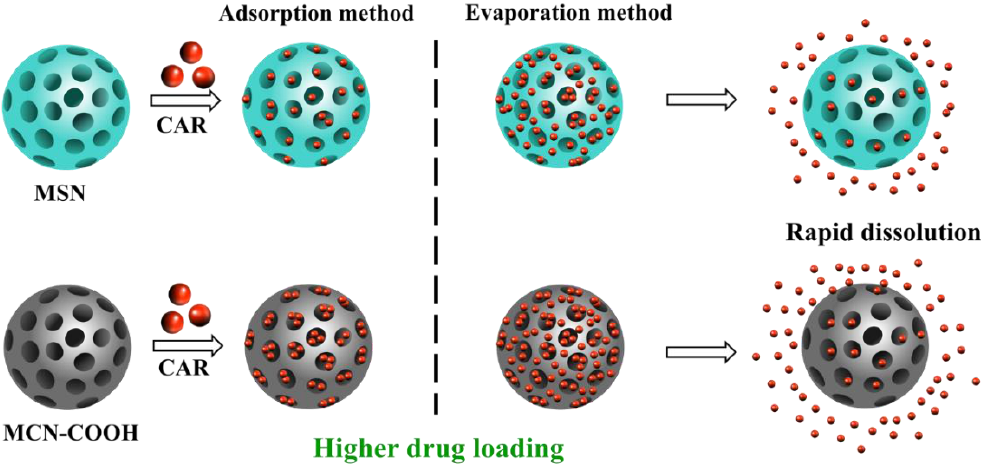
Figure 1. Schematic illustration of mesoporous silica nanoparticles (MSN) and mesoporous carbon nanoparticles (MCN)–COOH as the carriers for water–insoluble drug carvedilol by solvent adsorption method and solvent evaporation